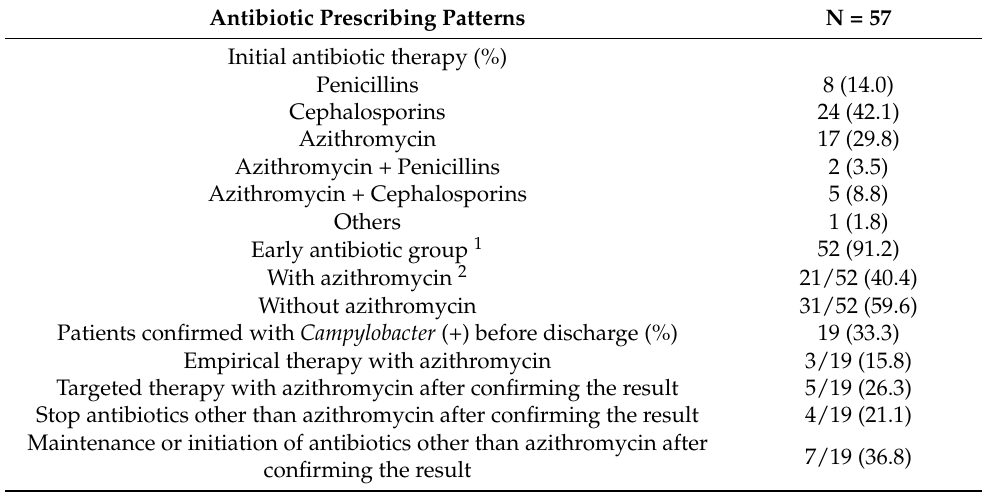
Table 2. Antibiotic prescribing patterns.